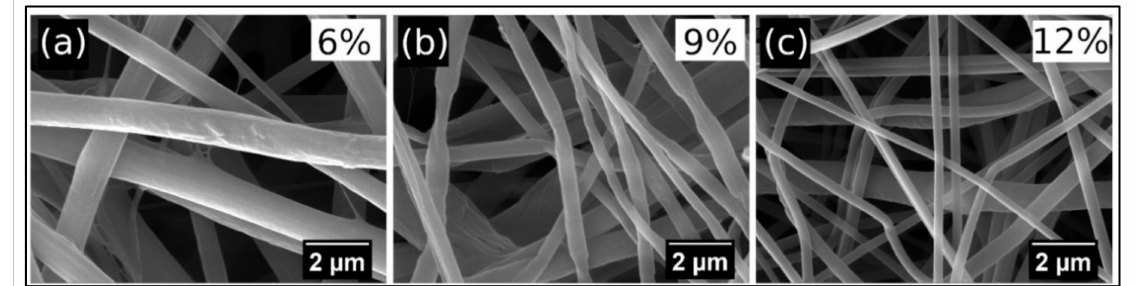
Figure 5. SEM images of PCL/Gel nanofibers doped with 6 wt.%, ( a ), 9 wt.% ( b ), and 12 wt.% ( c ) magnetized halloysite. Magnification = 25,000 × .